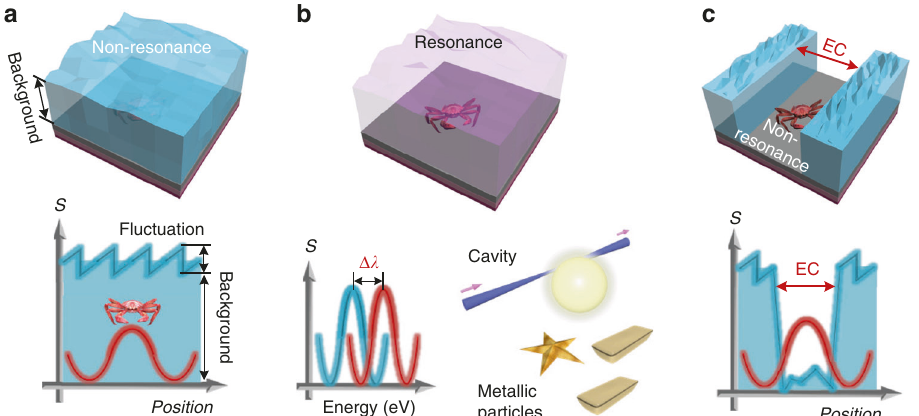
Fig. 1 Concept artwork explaining visualizable nanoscale detection with an electromagnetic canyon. a Artwork showing the dif fi culty in sensing nanoscale objects (represented by a crab) in conventional imaging modalities because of the sea of electromagnetic background signals (represented by blue water) and fl uctuations (represented by sawtooth waves). b Artwork and schematic showing the mechanisms of resonance-based nanoscale sensing such as the shift in the mode spectrum of a microcavity or of the localized surface plasmon resonance in a metallic particle system. c Artwork showing the proposed framework of visualizable nanoscale sensing by arti fi cially creating an electromagnetic canyon. The blue and red curves in each sub- fi gure denote the electric fi eld strength of the background and of the nanoscale object, respectively. The crab, star, and gold bars were adapted from TurboSquid with the Royalty Free License (all extended